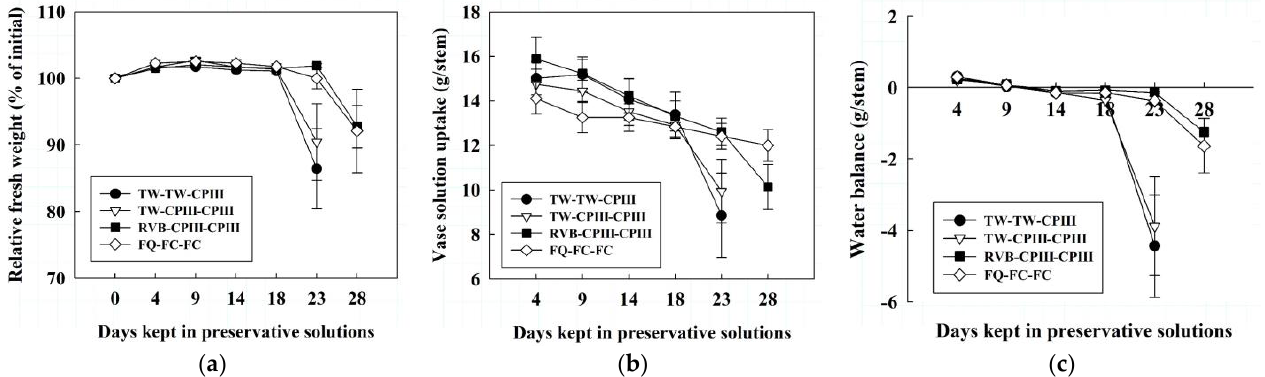
Figure 5. Changes in the relative fresh weight in ( a ) vase solution uptake, ( b ) water balance, and ( c ) cut hydrangea flowers ‘Verena’ by solution combination for each postharvest treatment stage in 2020. Vertical bars indicate standard deviation of means ( n = 9). TW, tap water; CP Ⅲ , 1% Chrysal Professional Ⅲ ; RVB, 0.1% Chrysal RVB; FQ, Floralife Quick Dip; and FC, Floralife Clear. The order of TW–TW–CP Ⅲ indicates the order of pretreatment solution, transport solution, and preservation solution.